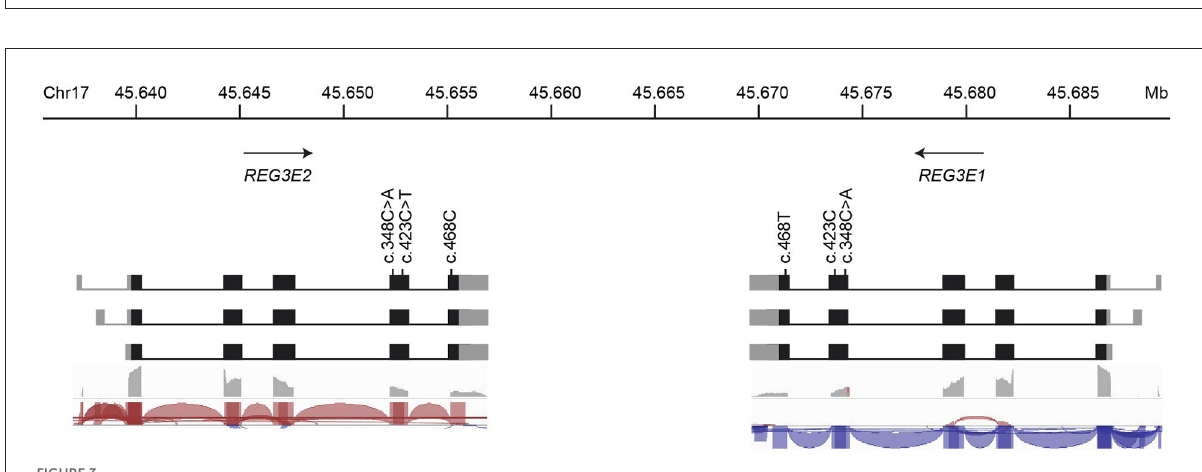
FIGURE3 Schematic representation of the genomic organization, nucleotide variations, and transcript variants of REG3E1 and REG3E2. The longest transcript isoforms (top row) are the most prevalent ( > 50%), whereas the shortest, lacking exon 1, are the least common ( < 10%) for both genes. The bottom two rows represent sashimi plots from screenshots of the Integrative Genomics Viewer using RNA-Seq data from Barkbase. Note that due to the almost complete sequence identity between REG3E1 and REG3E2 , transcript reads cannot be mapped reliably to either